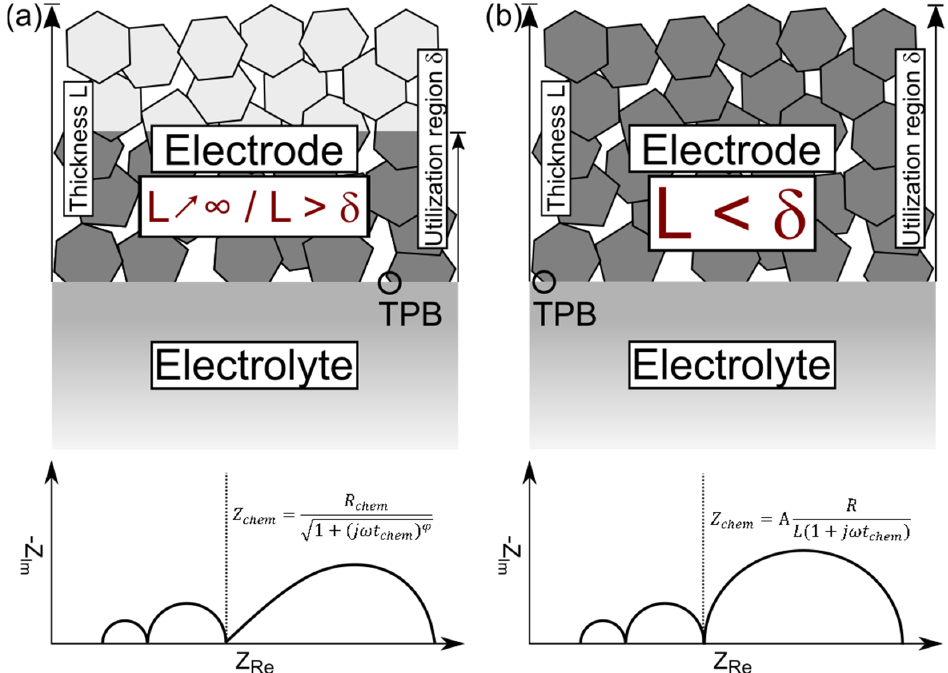
Figure 15. Schematic of the penetration of the utilization region δ into the electrode in dependency of its thickness L with the corresponding impedance models: ( a ) depicts the relation represented by Equation (2); ( b ) illustrates the case discussed for Equation (12).